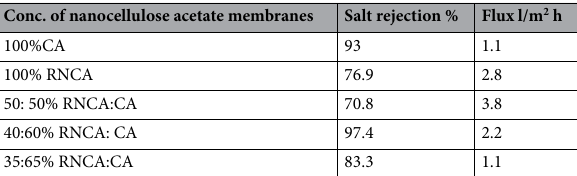
Table 2. Effect of concentration nano cellulose.